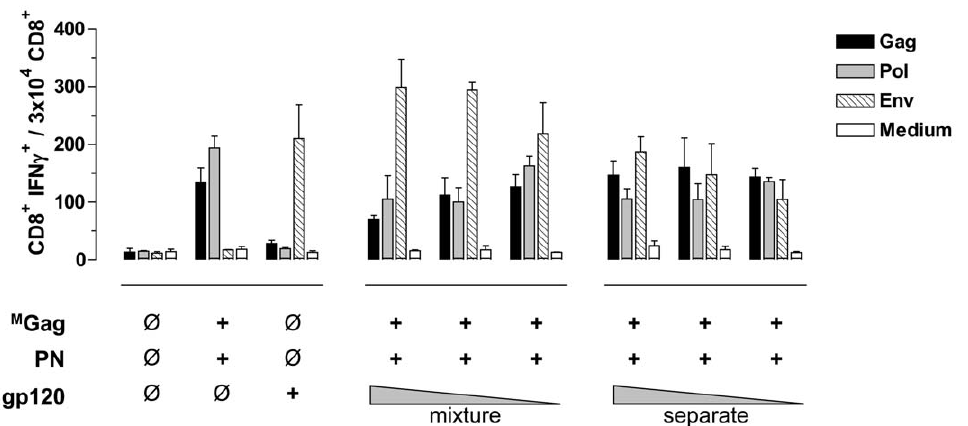
Figure 6. Effect temporal separation of Gag-Pol-Nef and gp120 administration on Gag- and Pol-specific CD8 + T cell responses. BALB/ c mice (n=6 per group) were i.m. inoculated at day 0 with a mixture of M Gag and PN; M Gag, PN, and gp120; or M Gag and PN, followed by a booster immunization with gp120 two weeks later (d 14); or vice versa, a mixture of M Gag and PN, or M Gag, PN and gp120 at day 14; or primed at day 0 with gp120 followed by a booster immunization with M Gag and PN at day 14. At day 29, spleen cells were isolated and tested for specific cellular immune responses by measuring IFN c production after stimulation with Gag (black), Pol (grey) or Env (hatched) specific peptides. IFN c production was determined by FACS analysis after intracellular staining of IFN c . Cell culture medium served as a negative control. Data shown are representative of two experiments.